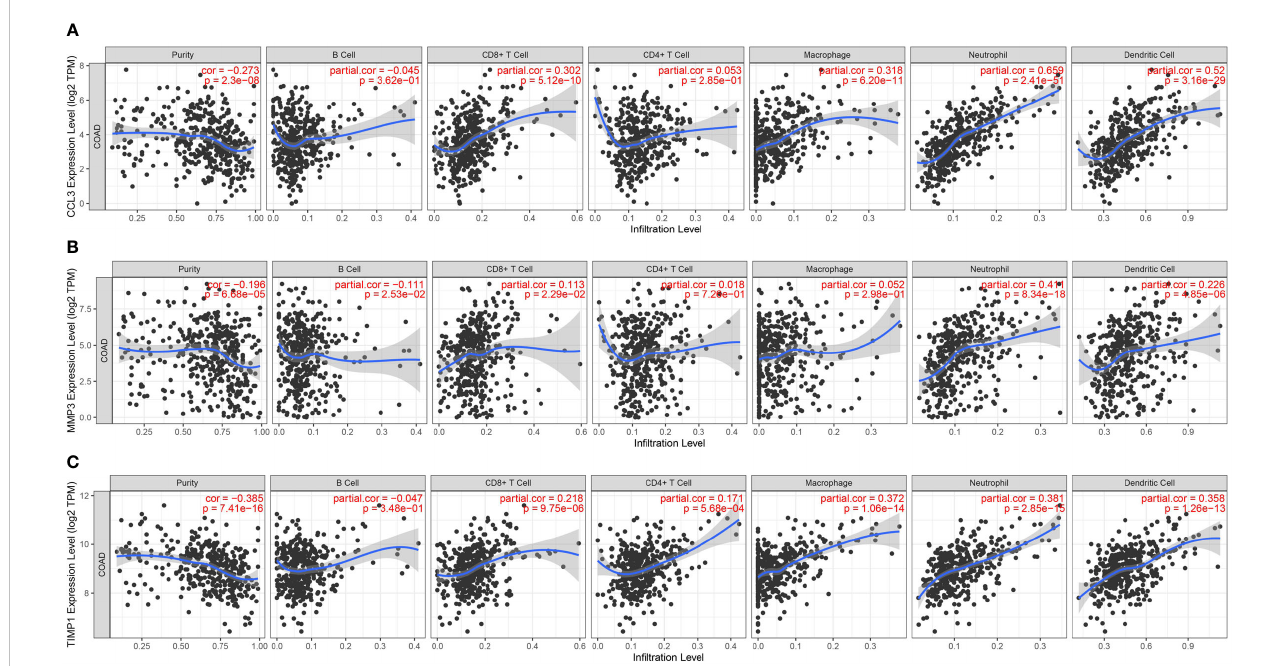
FIGURE 8 Relationship between CCL3, MMP3, and TIMP1 expression and level of immune cell in fi ltration in colon cancer. (A) CCL3. (B) MMP3. (C)